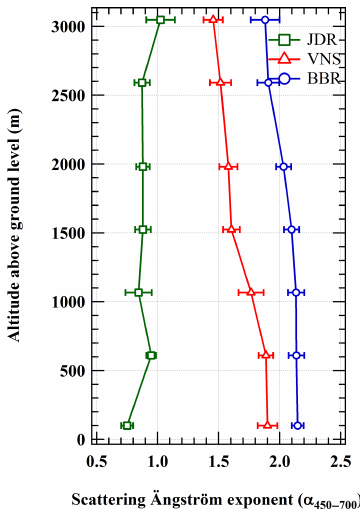
Figure 4. Altitudinal variation of α for the aircraft campaign sta- tions: JDR (square), VNS (triangle) and BBR (circle). Error bars represent the standard error in the mean of level-averaged α .